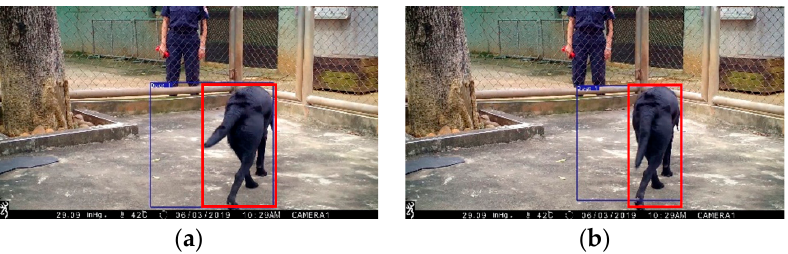
Figure 17. Dogs with incorrect tracked regions in images 47 and 48. ( a ) Image 47; ( b ) Image 48.